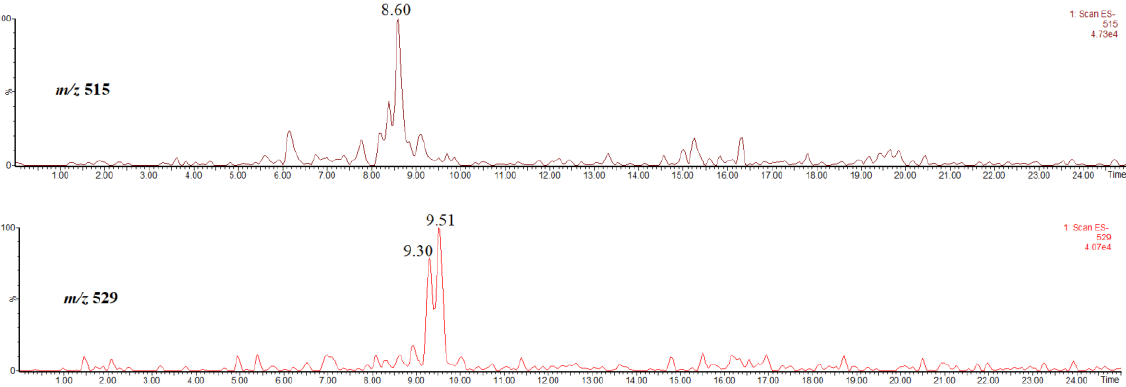
Figure 9. Single ion chromatogram of the ion at m/z 515, thus the [M-H] − ion of 3,5-di- O - caffeoylquinic acid and single ion chromatogram of the ion at m/z 529, thus the [M-H] − ion of methyl 3,5- O -dicaffeoylquinates.